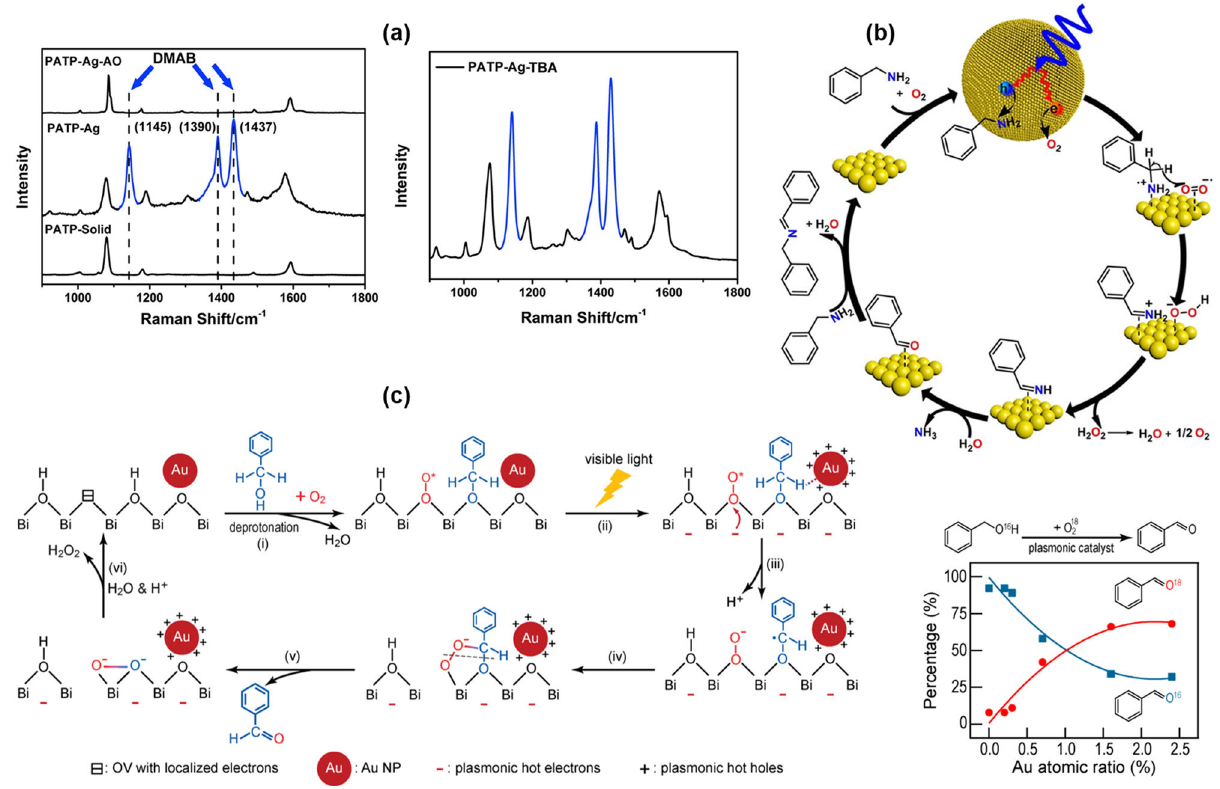
Fig. 10 Hot-holes driven organic reactions. a SERS demonstrating the oxidative conversion of PATP to DMAB on Ag nanoparticle. In the presence of ammonium oxalate (AO), a hole scavenger, the conversion does not occur, whereas in the presence of t-butanol (TBA), a hydroxyl radical scavenger, the reaction occurs. These observations suggest that holes drive the reaction (reprinted from ref. 96 ). b Plausible mechanism of plasmon-enhanced oxidative coupling reaction of benzylamine to N-benzylidenebenzylamine (imine), where the activation of both the reactants amine and O 2 occurs via capturing hot holes and electrons (reprinted with permission from ref. 13 ). c Plasmon-driven benzyl alcohol to benzaldehyde conversion on Au-BiOCl. Upon excitation, the oxygen vacancy on BiOCl traps the hot electron and synergistically the hot holes on Au NPs abstract α -H of benzyl alcohol which ultimately leads to the formation of benzaldehyde. The yield of 18 O leveled benzaldehyde increases with the increase in the loading of Au in Au-BiOCl (reprinted with permission from ref. 99 copyright © 2017, American Chemical